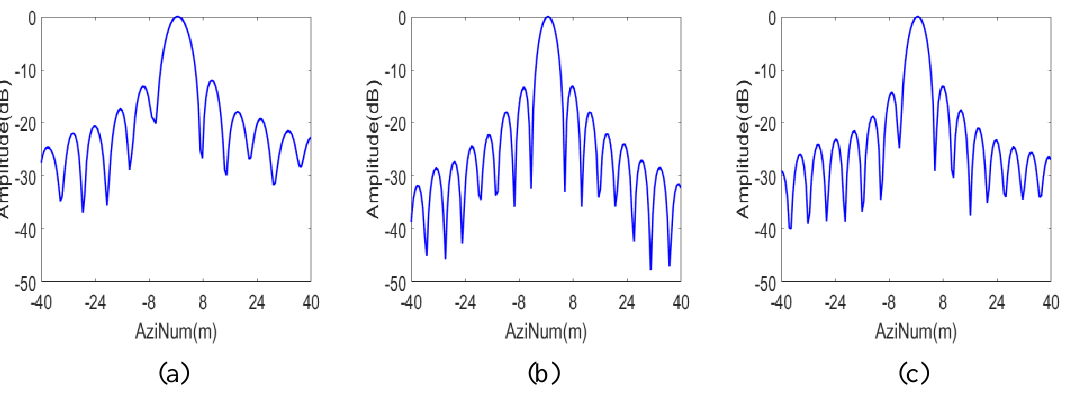
Figure 11. Azimuth profile of the targets of the scheme proposed in [18]. ( a ) Target D; ( b ) Target E; and ( c ) Target